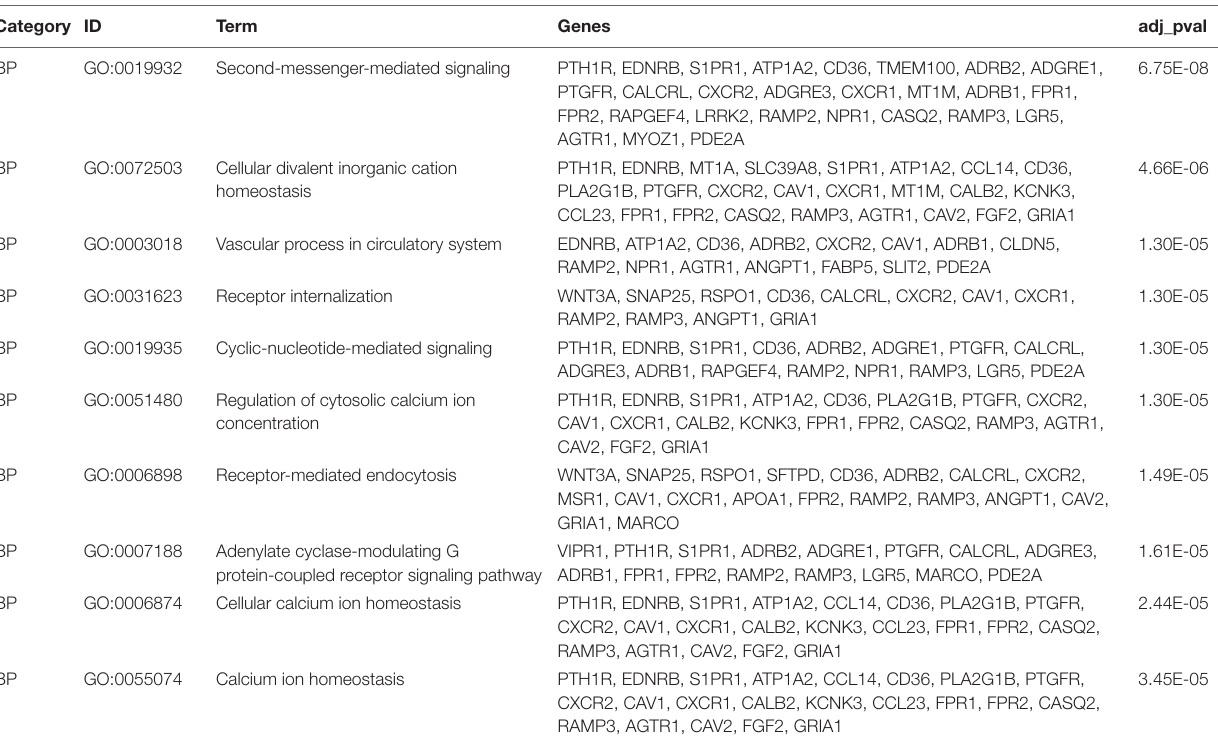
TABLE 5 | The top 10 gene ontology (GO) terms of differentially expressed genes in cluster